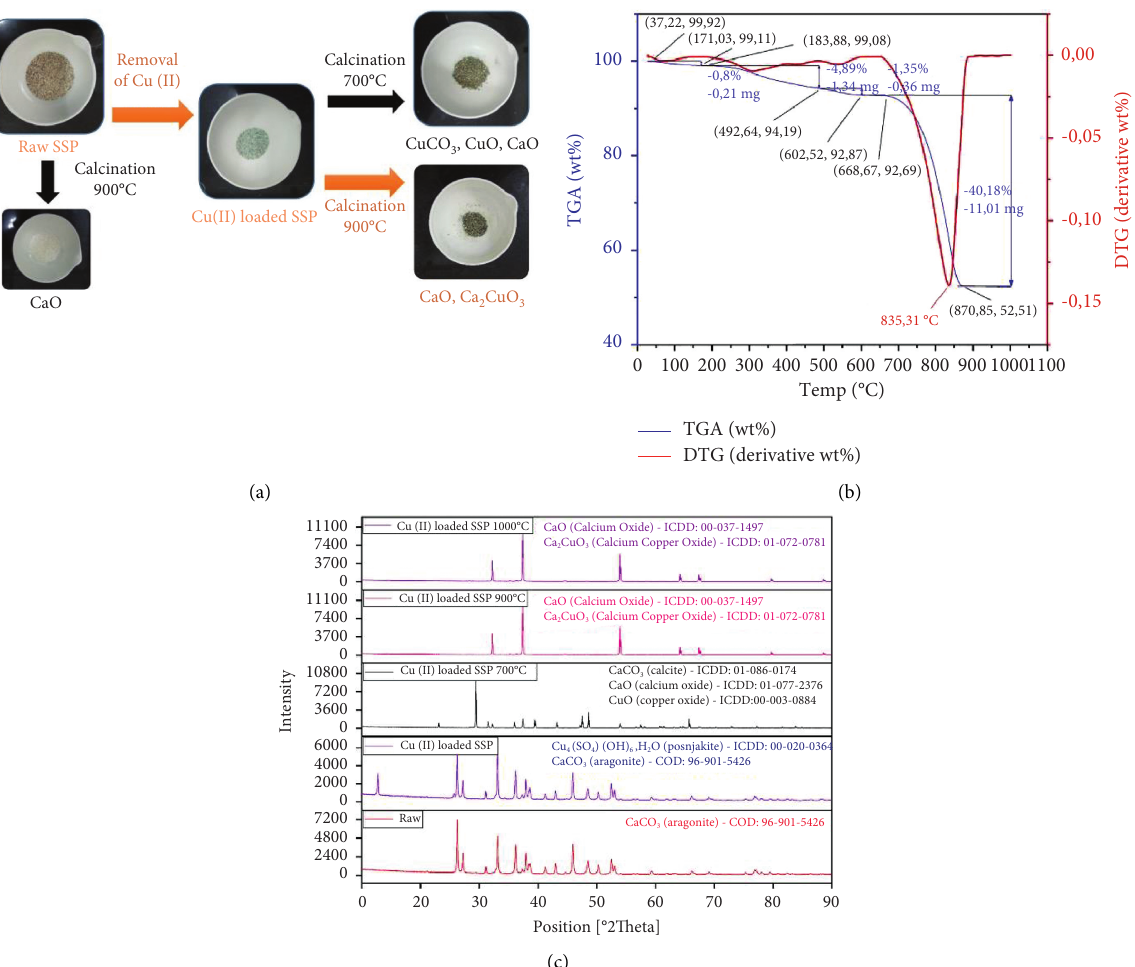
Figure 7: (a) Calcination of Cu(II) loaded SSP. (b) Thermogravimetric Analysis (TGA) and derivative thermogravimetry (DTG) profiles of SSP. (c) XRD patterns comparison for raw SSP, Cu(II) loaded SSP, and Cu(II) loaded SSP calcined at 700, 900, and 1000 ° C along with